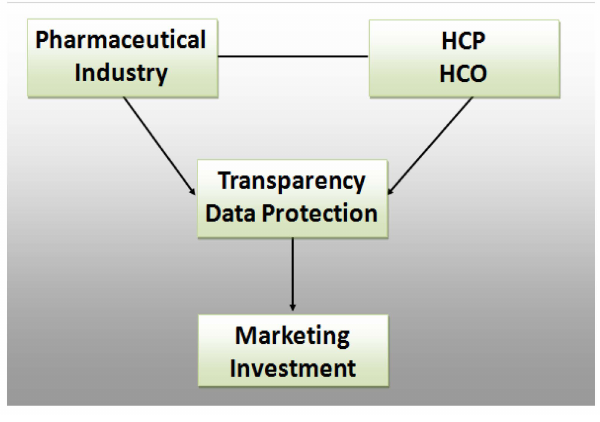
Figure 3. Research